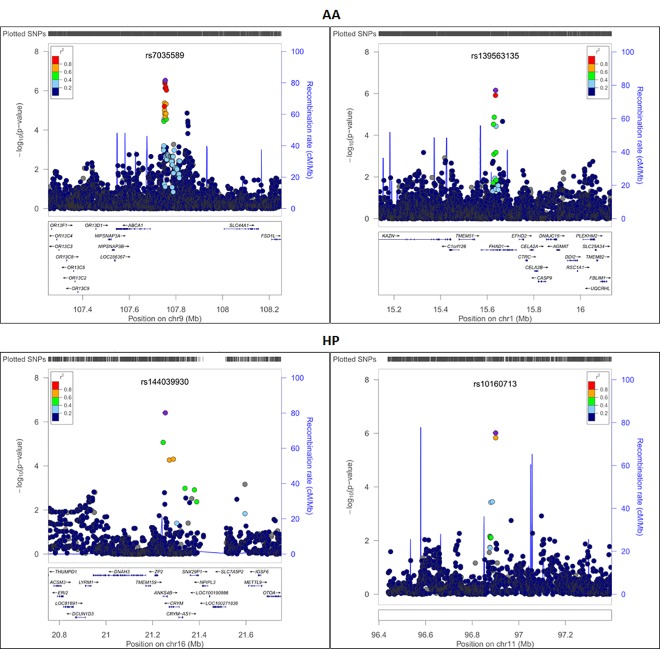
Regional association plots showing–log10(p-values) against base-pair position for African American (AA) (top) and Hispanic (HP) (bottom) women considering grade 0 vs. 1–3 analyses.